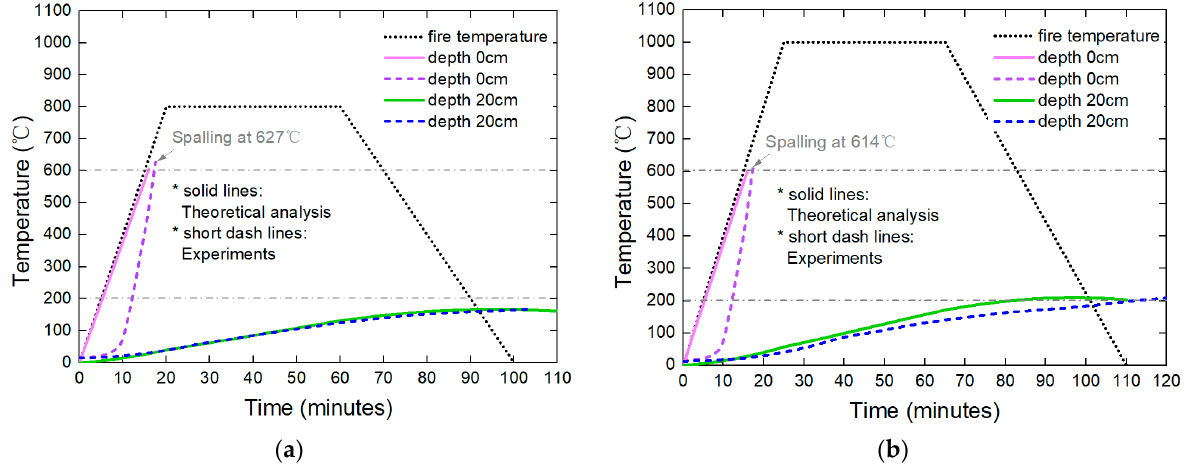
Figure 12. Comparison between theoretical analysis and the experiment results: ( a ) 800 °C; ( b ) 1000 °C.